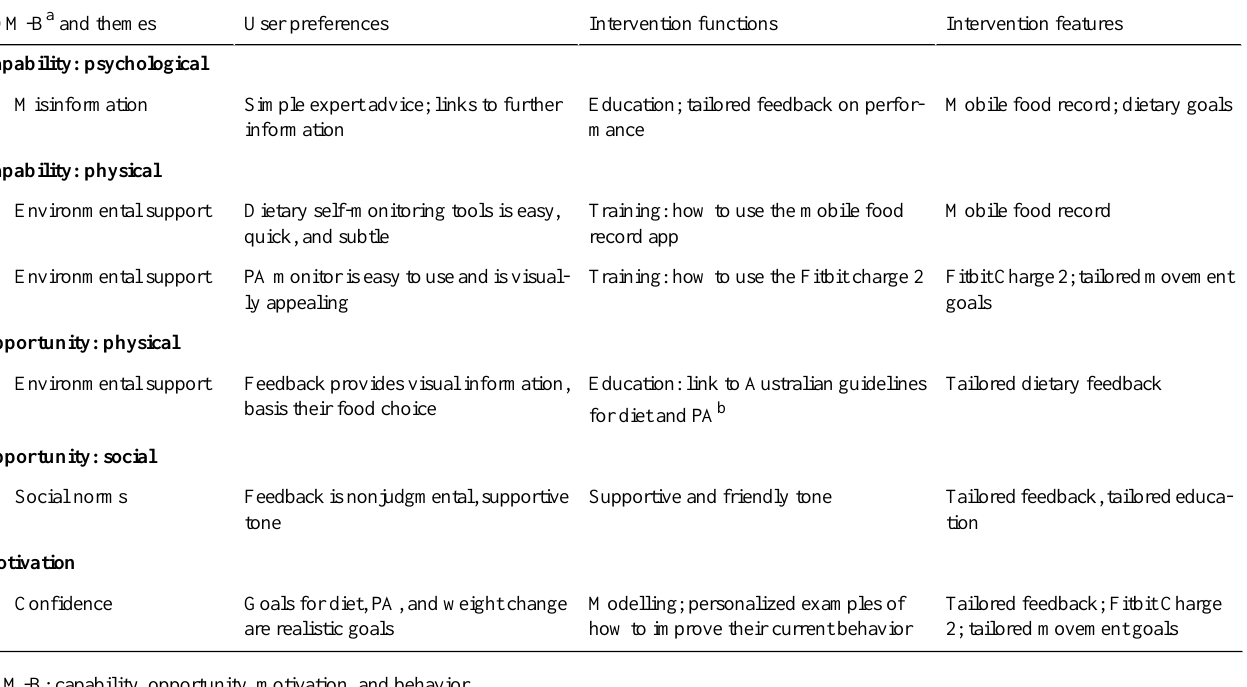
Table 4. Summary of stages of applying capability, opportunity, motivation, and behavior framework to the focus groups and interview data to identify nutrition, physical activity, and weight management intervention functions and